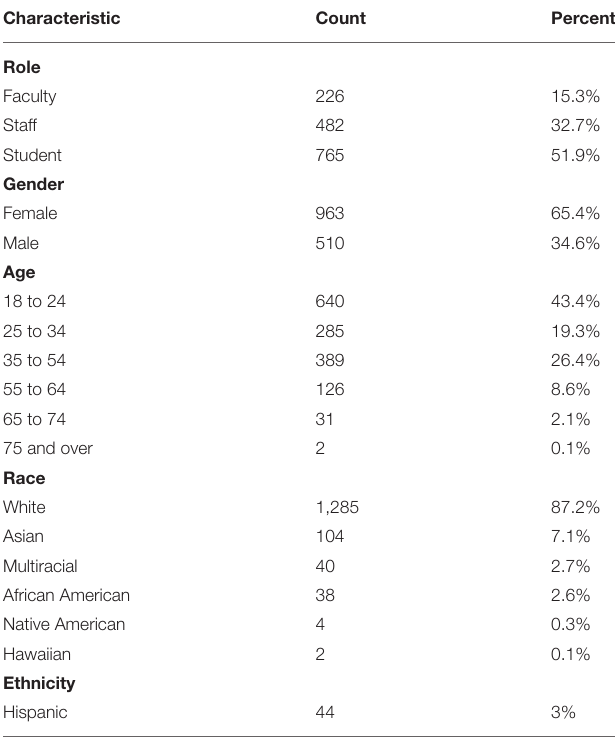
TABLE 1 | Sample characteristics ( N =